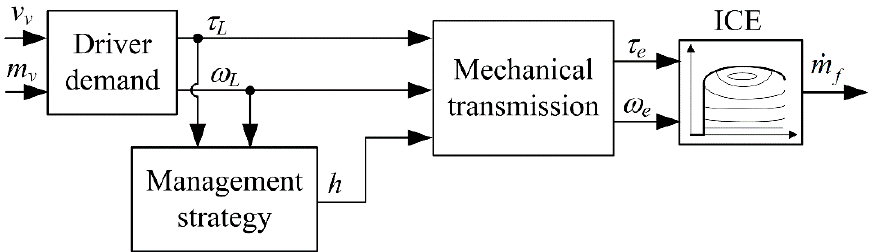
Figure 1. Delivery truck MAN TGM 15.240.